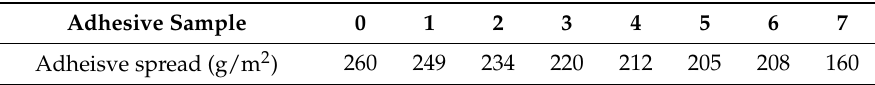
Table 2. The adhesive spread of the different adhesives,